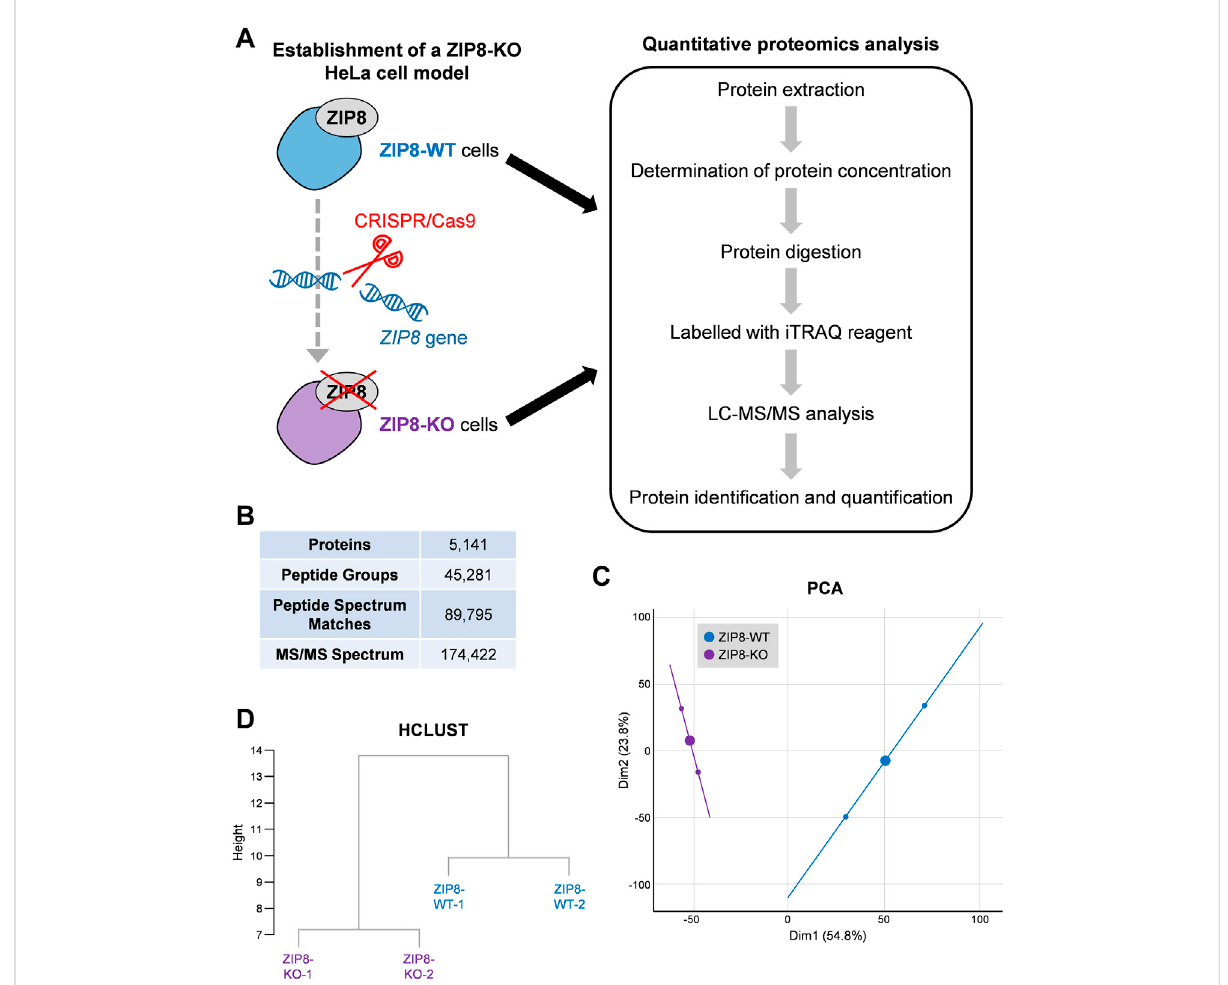
FIGURE 1 QuantitativeproteomicanalysisofhumancellswithZIP8-wildtype(WT)or-knockout(KO). (A) Schematicdiagramofthecellmodelssubjected to iTRAQ-based comparativeproteomicanalysisin thisstudy. (B) LC-MS/MS data after searching against Homo sapiens protein database for protein identi fi cation and quanti fi cation. (C,D) Principal component analysis (PCA) (C) and cluster dendrogram (HCLUST) (D) of all identi fi ed proteins between ZIP8-WT and ZIP8-KO